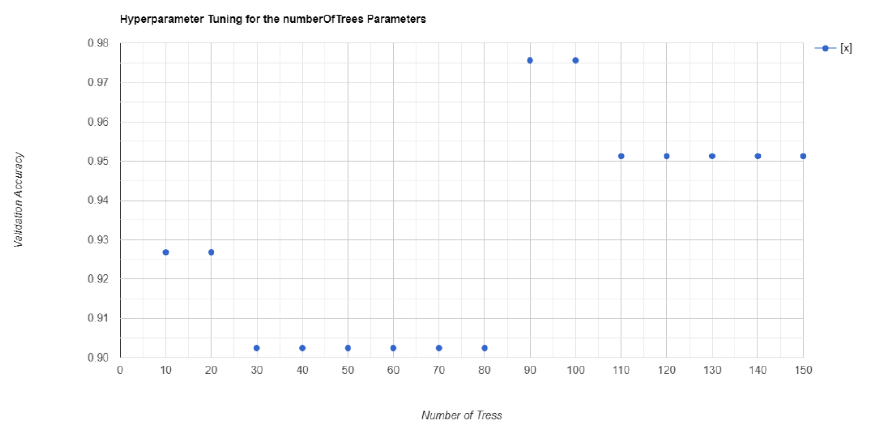
Figure 3. Example of hyperparameter tuning of random forest classification applied to case study ID 5 (Table 1).